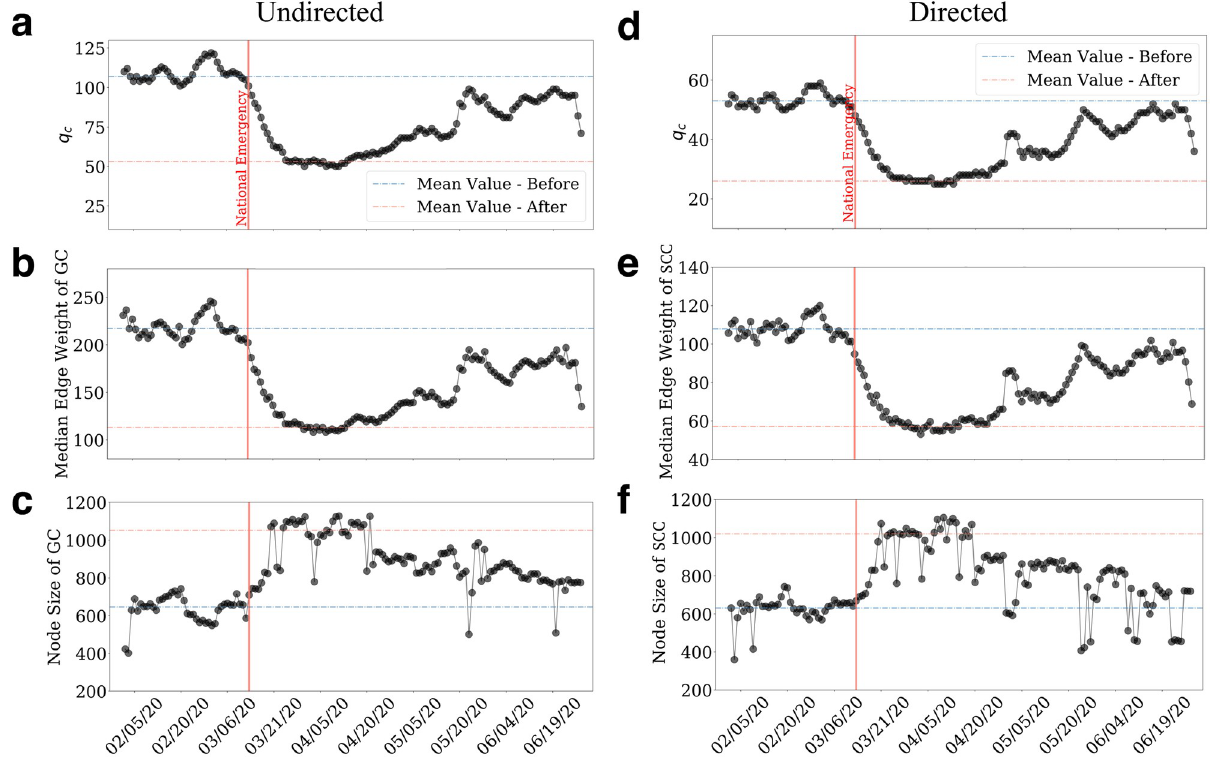
Fig 4. The changes of the percolation metrics using a 7-day moving window to smooth out the weekend/weekday fluctuations. a and b , the changes of q with time and the median edge weights of the largest component which reflects the connection strength. c , the changes in the sizes of the largest c strongly connected component for undirected graphs. d,e and f show the directed graph’s scenario for q node size. Grey lines indicate the time series of the undirected graphs while blue ones are for directed graphs. The red vertical line highlights the time of the national emergency declaration (March 1, 2020) while the blue and red horizontal lines indicate the mean value of each feature before and after the